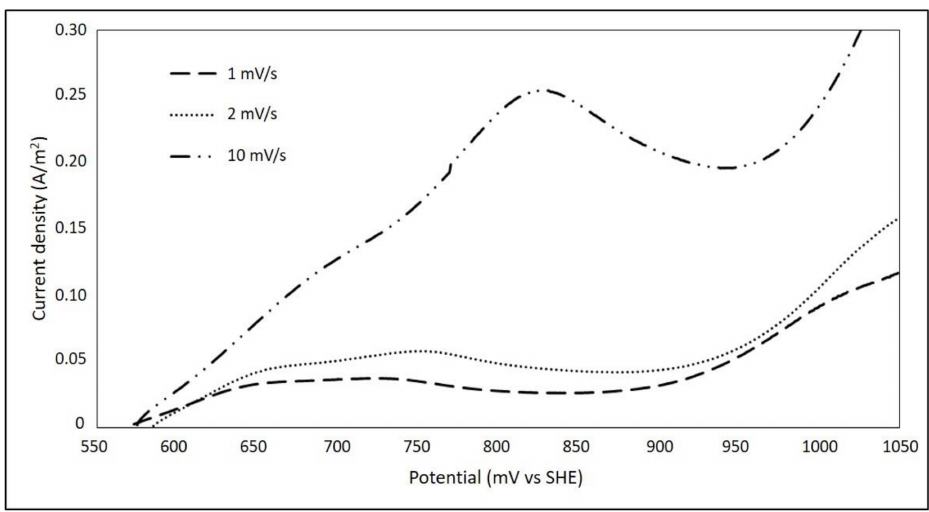
Figure 3. Effect of the sweep rate at 1, 2 and 10 mV/s on the chalcopyrite electrode using a solution with 20 g/L [Cl − ]; 0.5 g/L [Cu 2+ ]; 1.0 g/L [Fe 2+ ], and pH 1 adjusted with sulphuric acid at 25 ◦